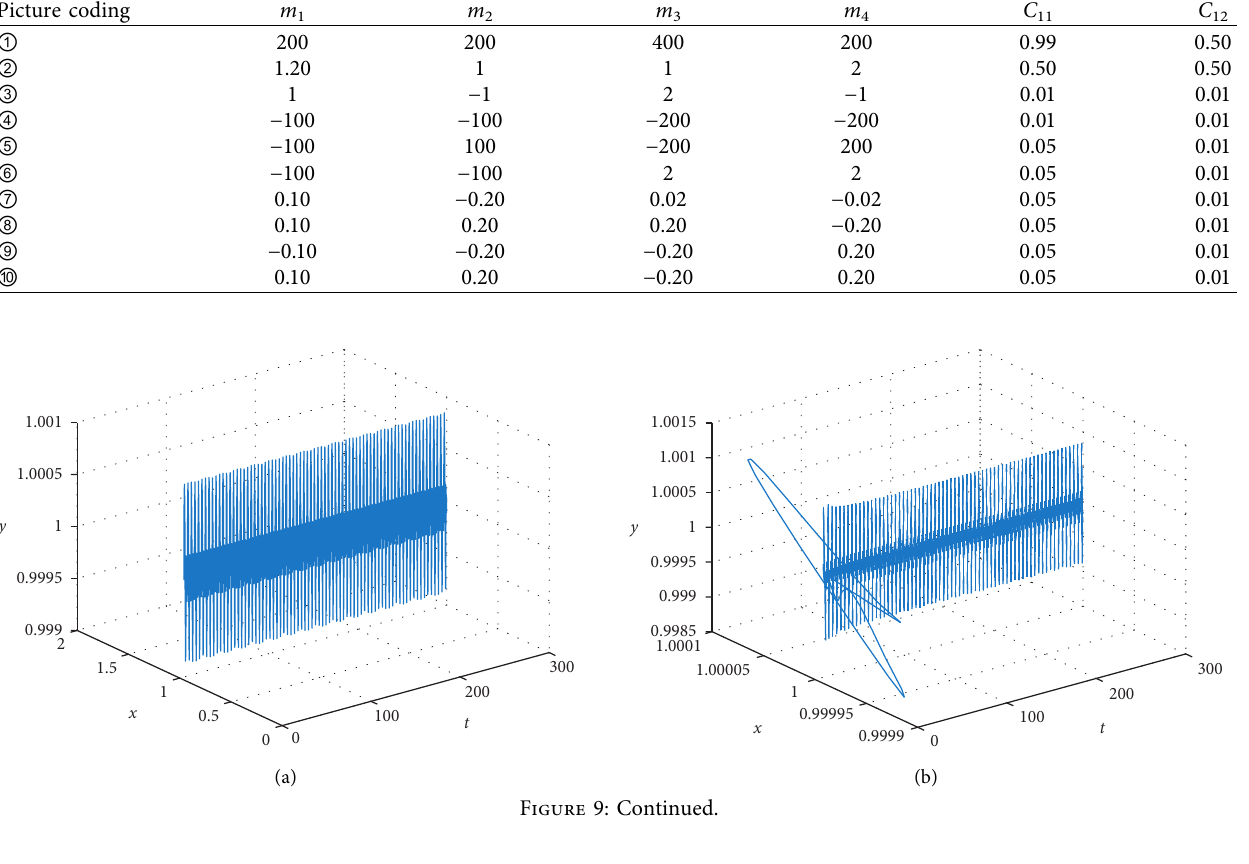
Table 10: Initial parameters of vertical enterprise.